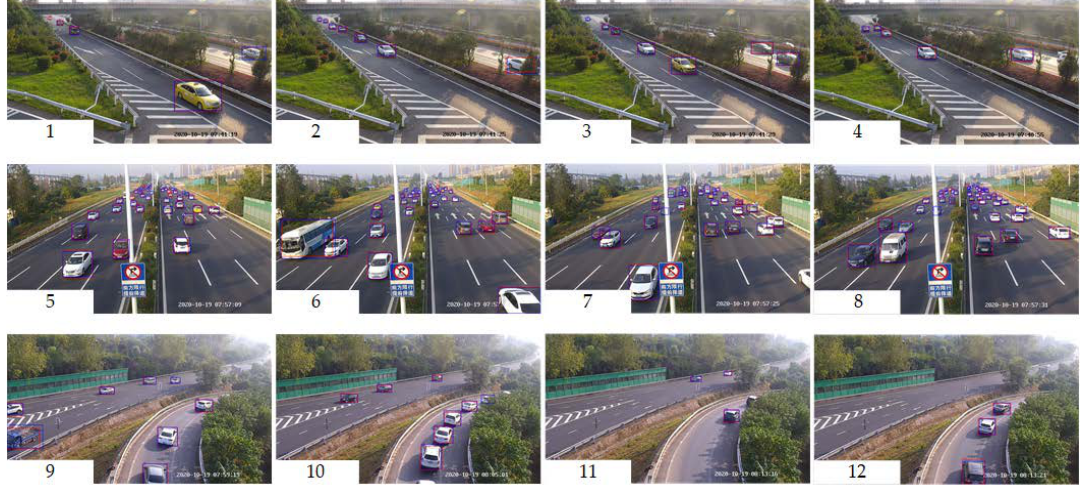
Figure 9. Qualitative detections of the E-YOLO and the YOLOv4-M on highway scenarios. The red bounding boxes are predicted by E-YOLO, the Blue bounding boxes are predicted by YOLOv4-M. Compared with the YOLOv4-M, which has a better detection toward the occlusion, the E-YOLO shows excellent performance on multi-scale recognition, especially for the cars. Best viewed on